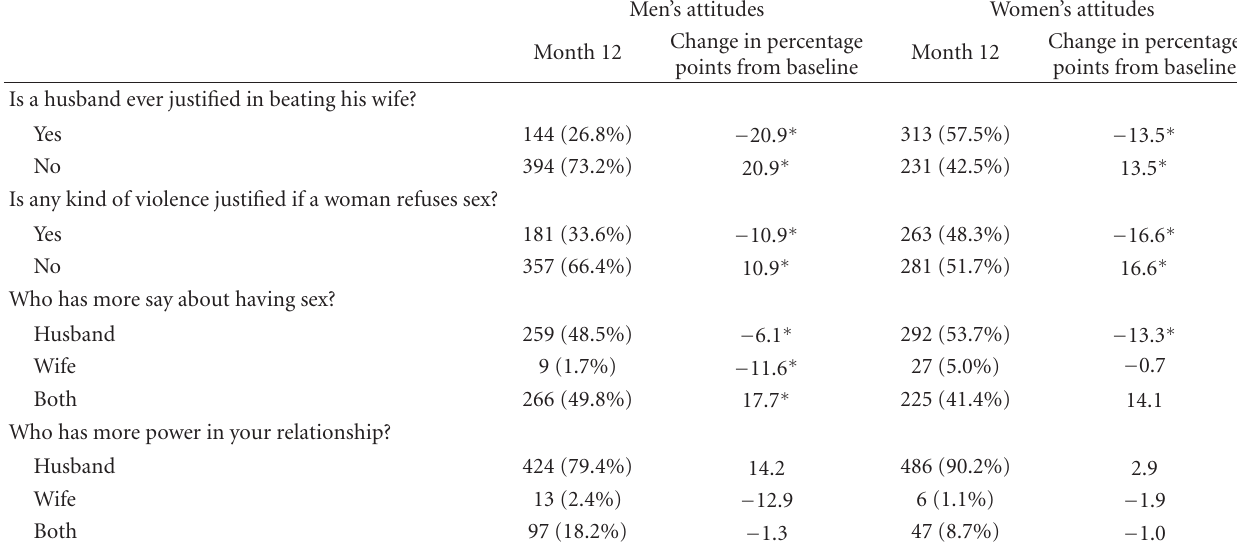
Table 2: Attitudes about IPV and opinions about relationship power at 12 months and changes over time.